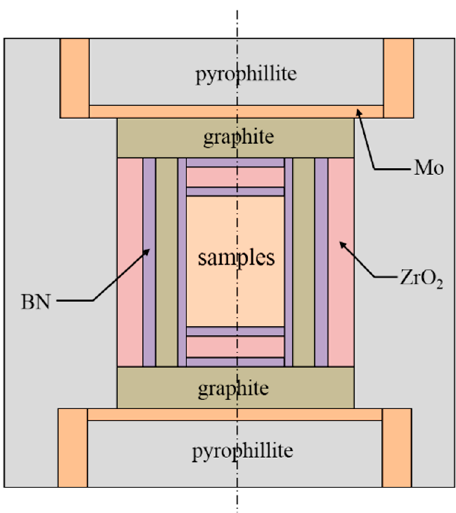
Figure 1. Schematic illustration of the assembly sample for high pressure solidification.